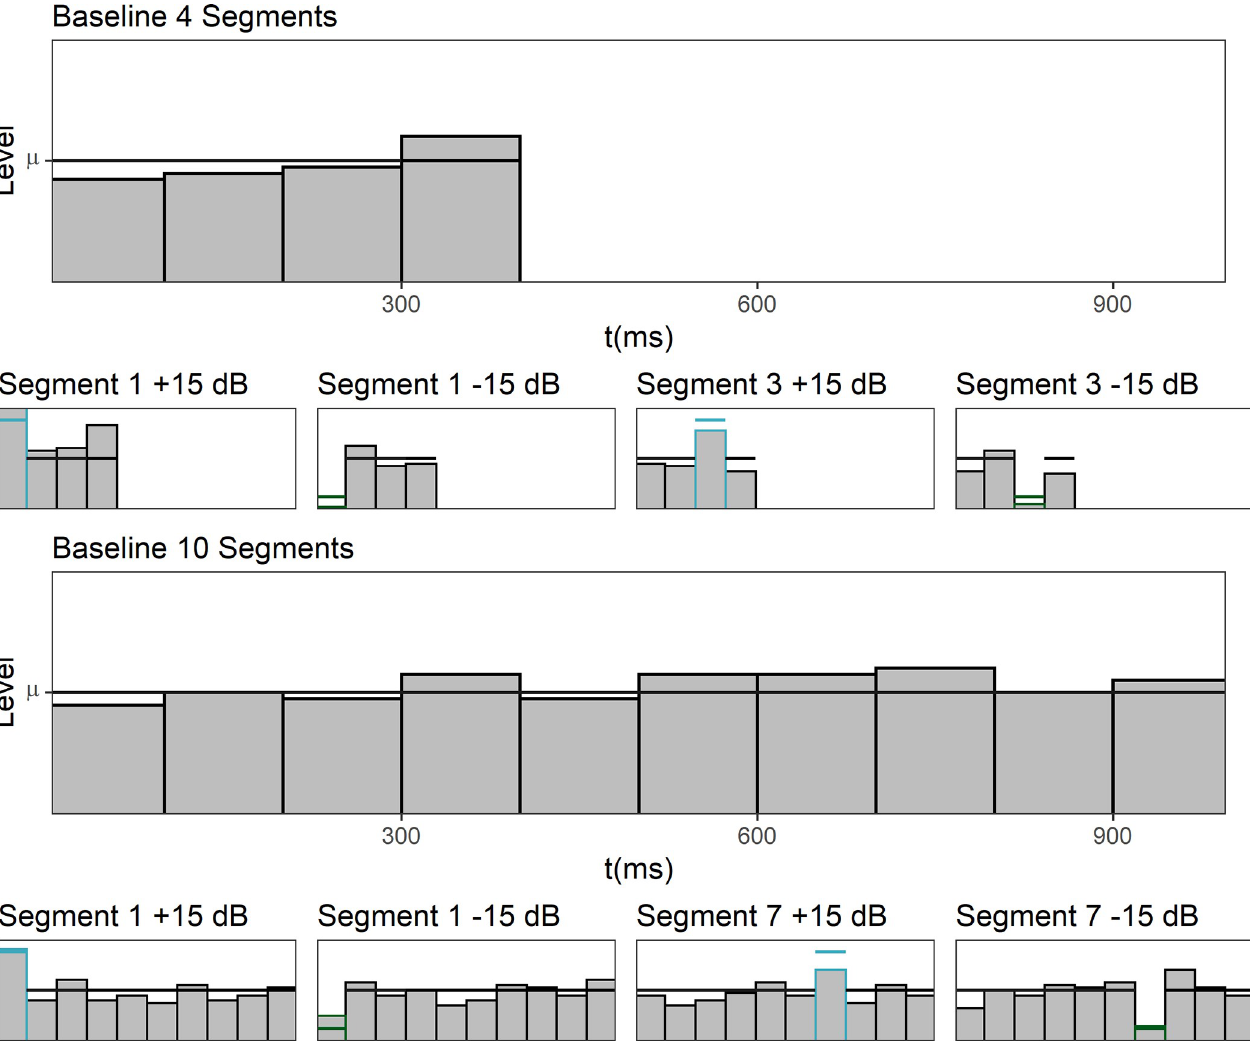
Fig 3. Experiment 2. Level profiles in the ten different conditions. The horizontal lines in each panel display the mean sound pressure level of the distribution from which the segment levels were drawn. The bars display the randomly selected segment levels within an example trial.